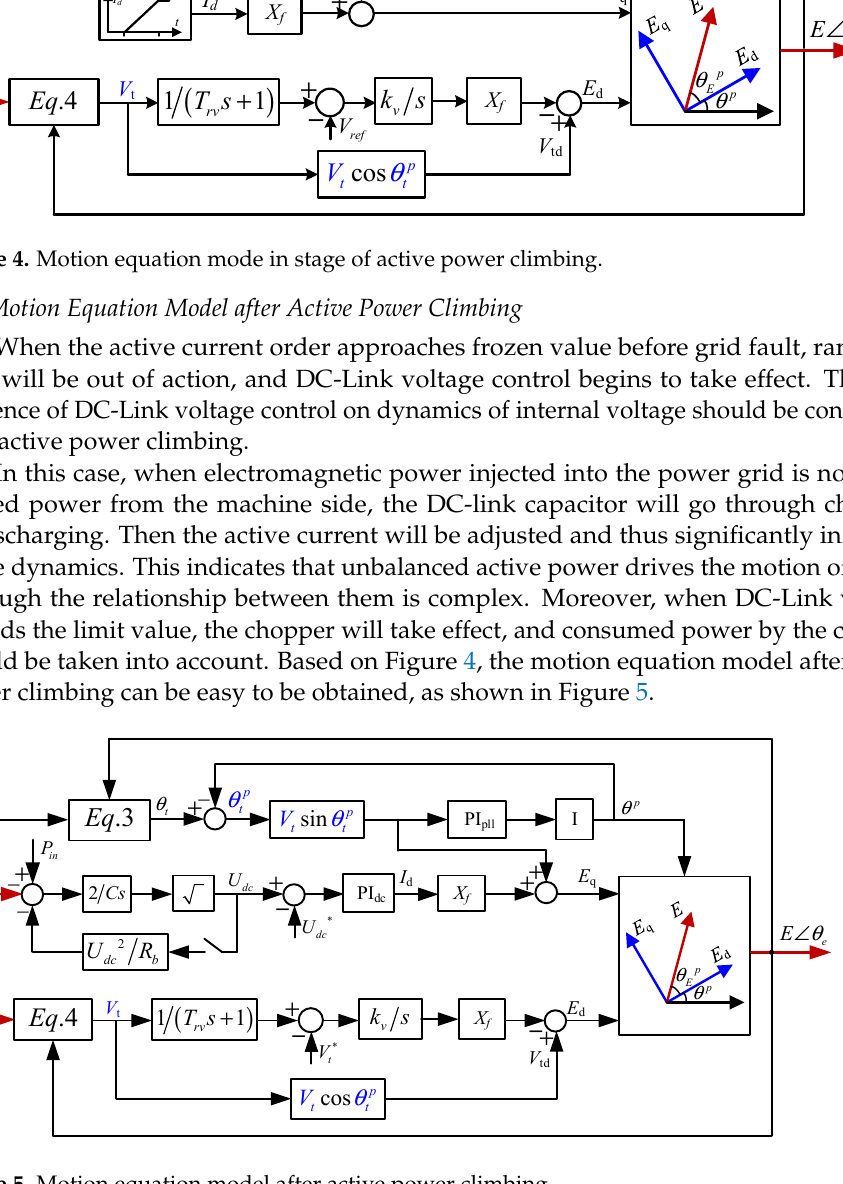
Figure 5. Motion equation model after active power climbing.